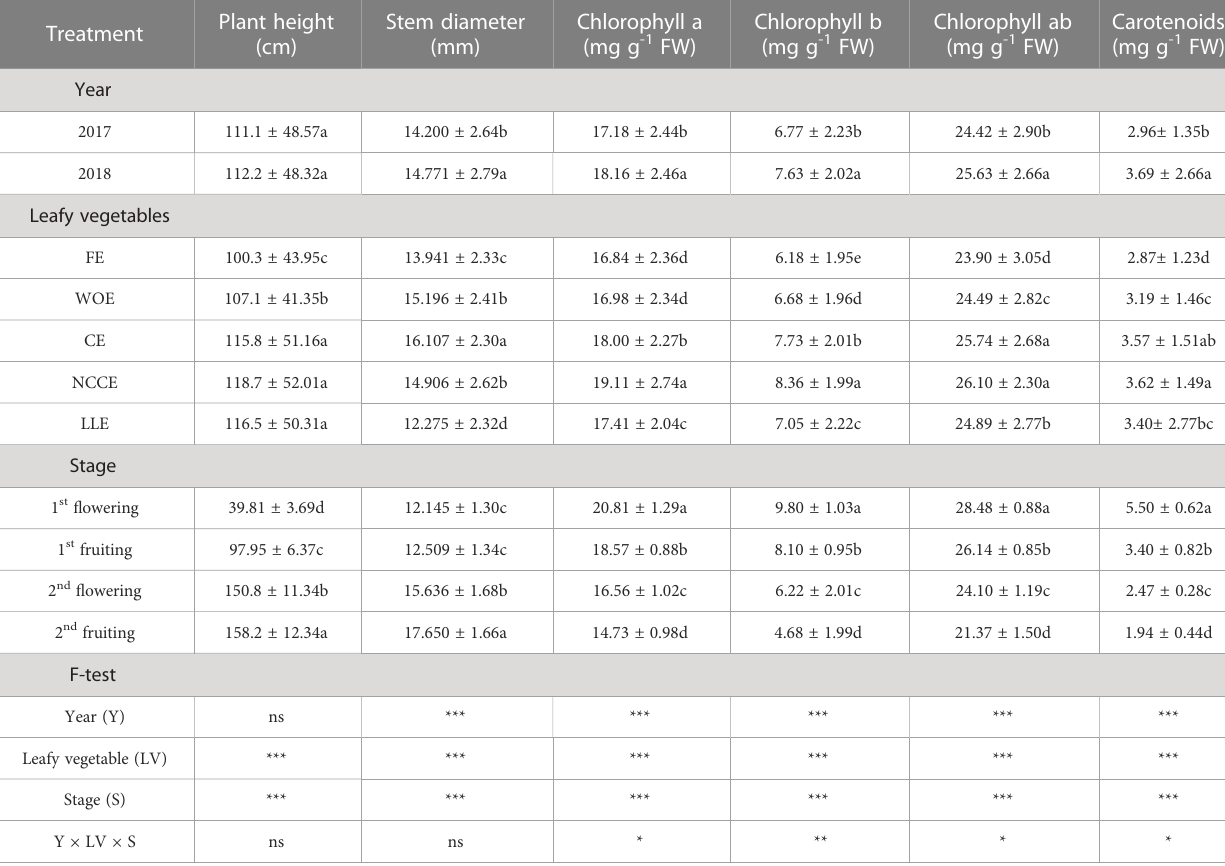
TABLE 1 Effect of different leafy vegetable rotation systems on morphological indexes and photosynthetic pigments of eggplant at different growth stages during the years 2017 and 2018.